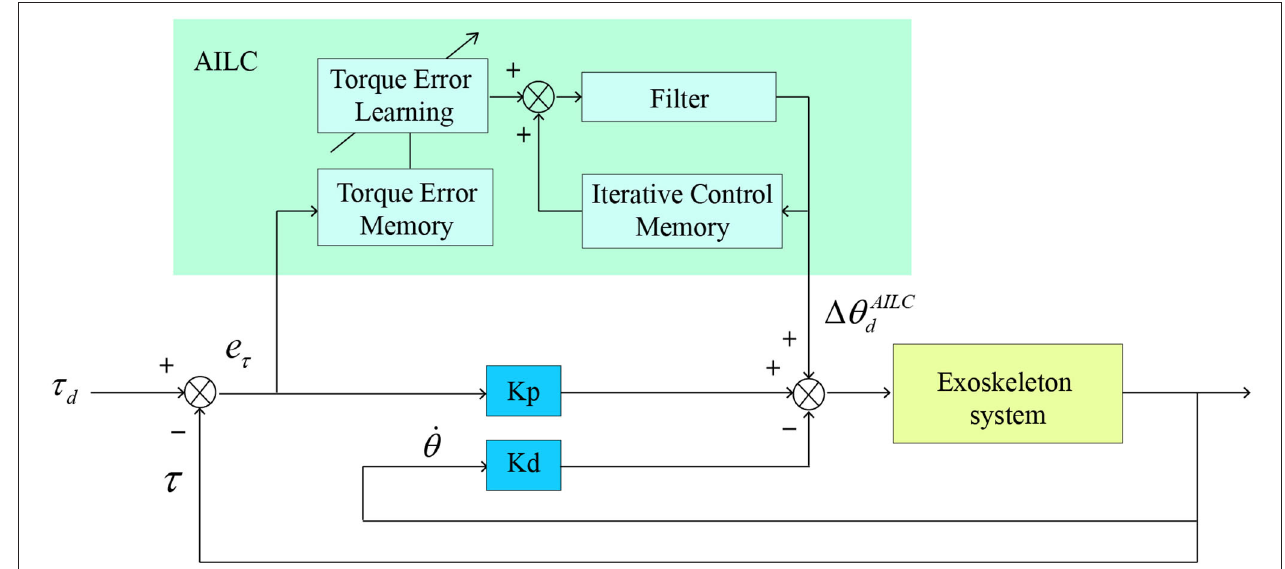
FIGURE 3 | Schematic of the proportional control, damping injection, and adaptive iterative learning algorithm (AILC).